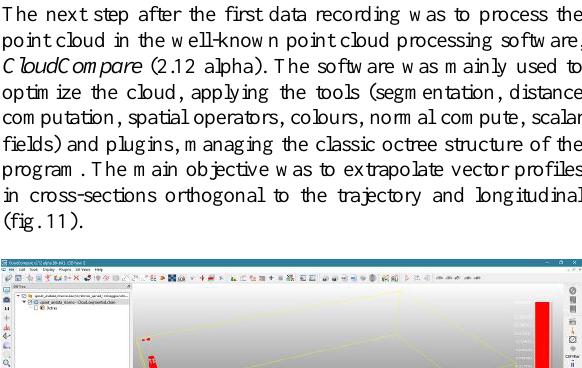
Figure 10 . Workflow processing and data integration.